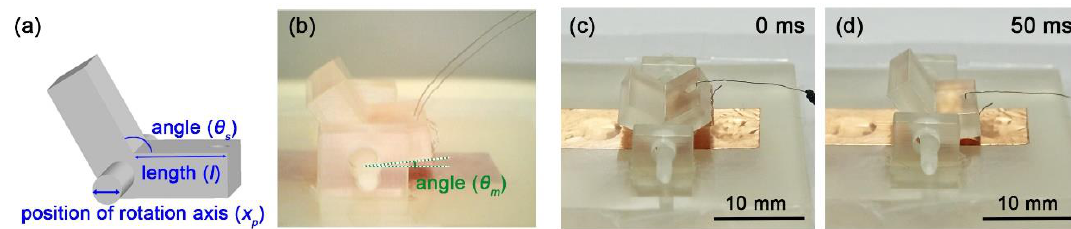
Figure 3. Operation of the V-shaped actuator. ( a ) Variables adjusted to find a suitable form. The schematics were drawn by the author using SolidWorks software (Dassault Systems SolidWorks Corp., USA). ( b ) Parameter to compare results. ( c , d ) Movement of the V-shaped actuator.